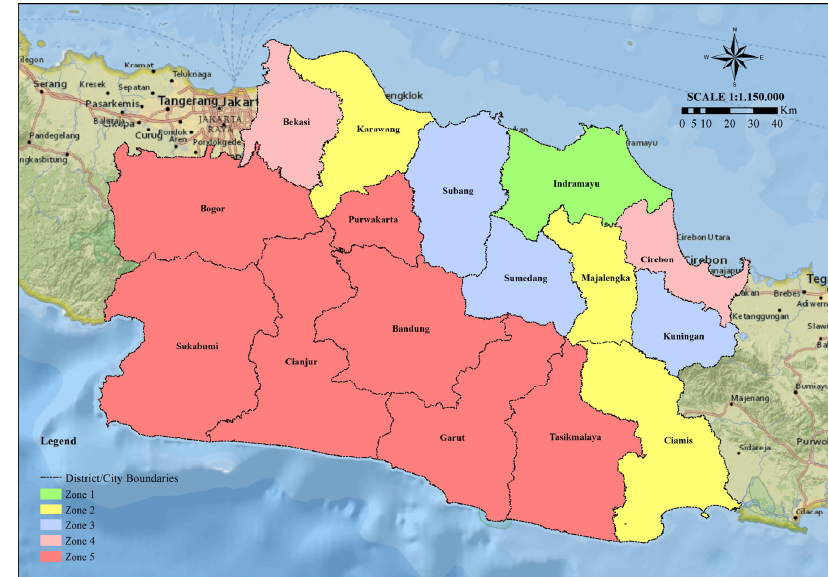
Figure 9. The final results of zone division use clustering type I Figure 9 shows that zone 5 is an area that has the highest loss potential compared to